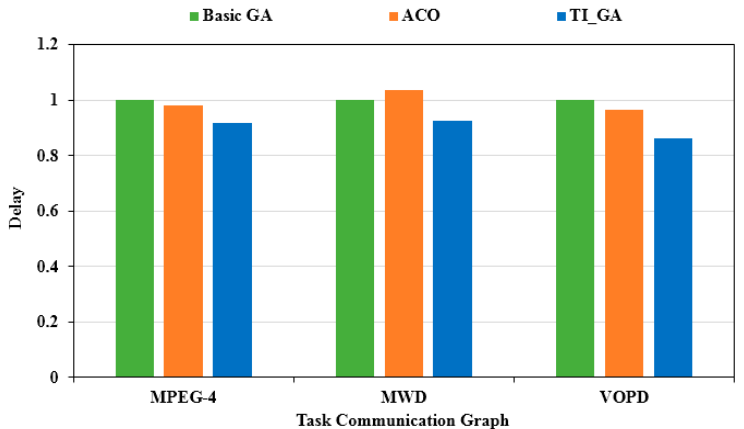
Figure 9. TI_GA, traditional genetic algorithm and ACO for MPEG-4, MWD, VOPD delay results comparison ( µ e : µ d = 1:1).